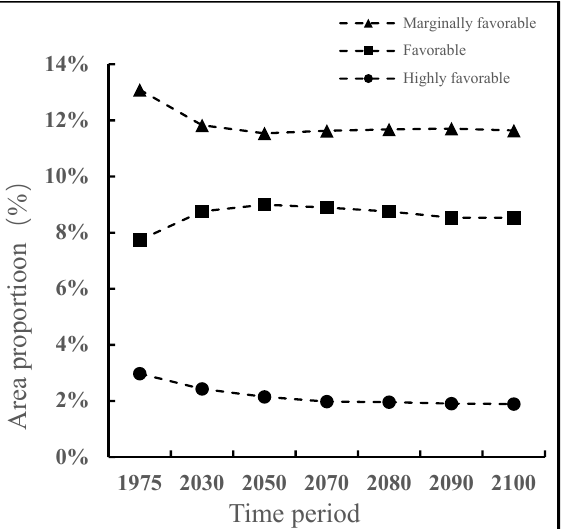
Figure 5. Proportion of the total distribution area of Apocheima cinerarius , represented by the various region during different periods.